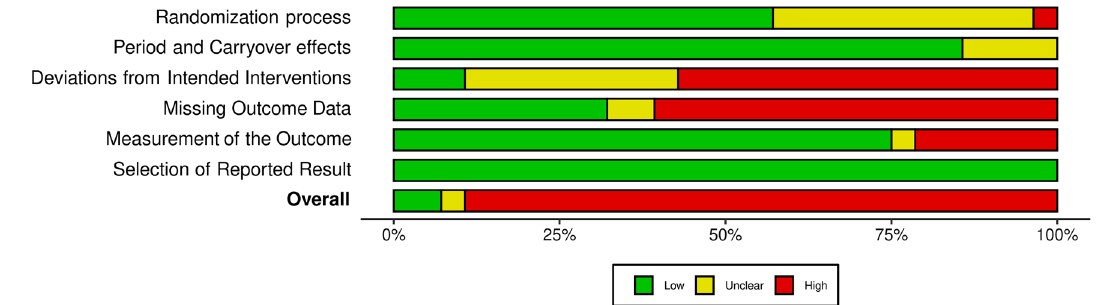
Fig. 4 Risk of bias between